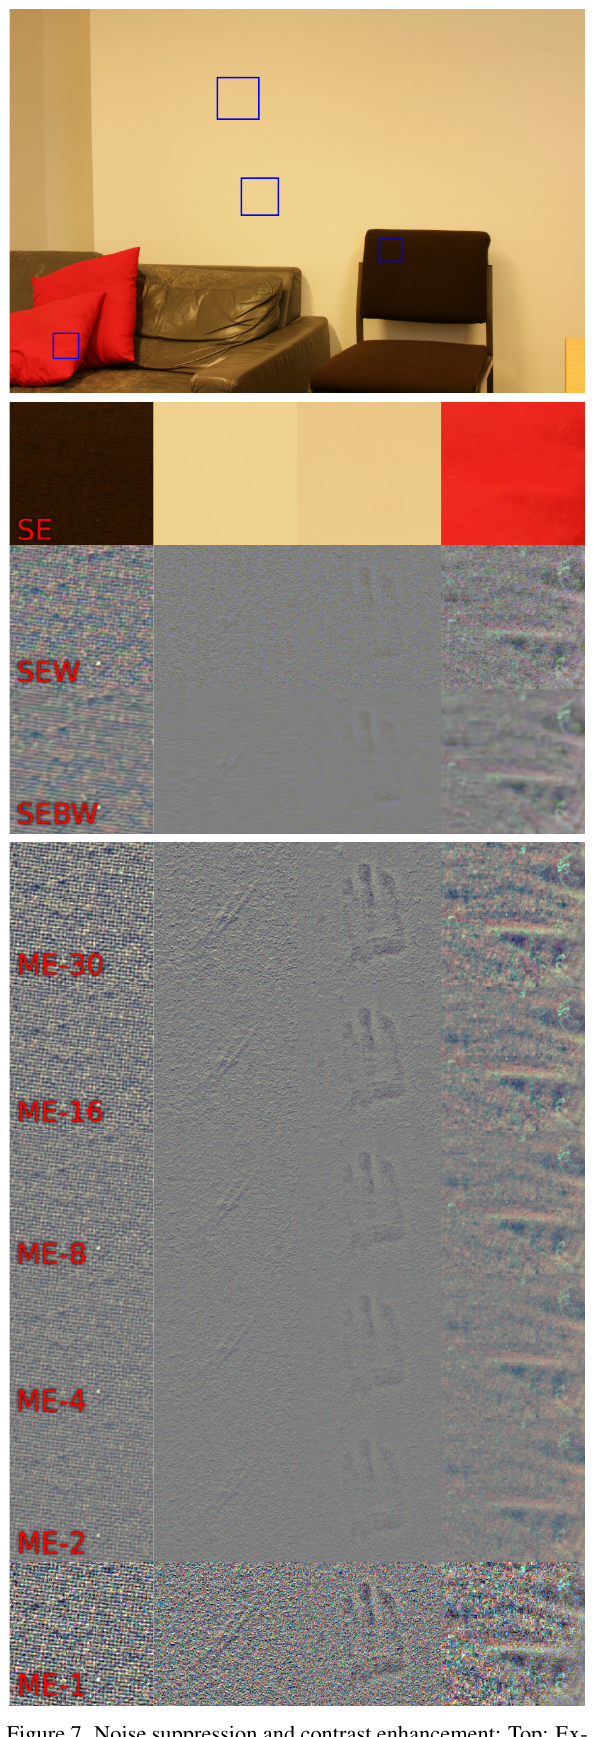
Figure 7. Noise suppression and contrast enhancement: Top: Ex- ample image (Cropped details marked in blue); From top to bot- tom: SE, SEW, SEBW, ME- 30 , - 16 , - 8 , - 4 , - 2 , - 1